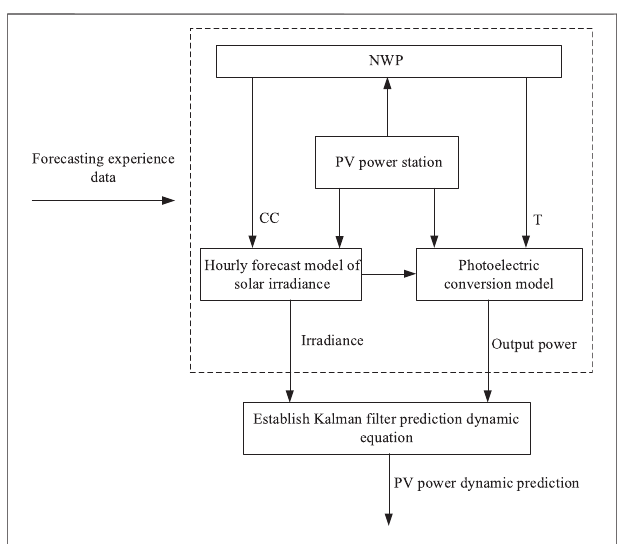
FIGURE 5 | Framework established by the Kalman fi lter dynamic equation.